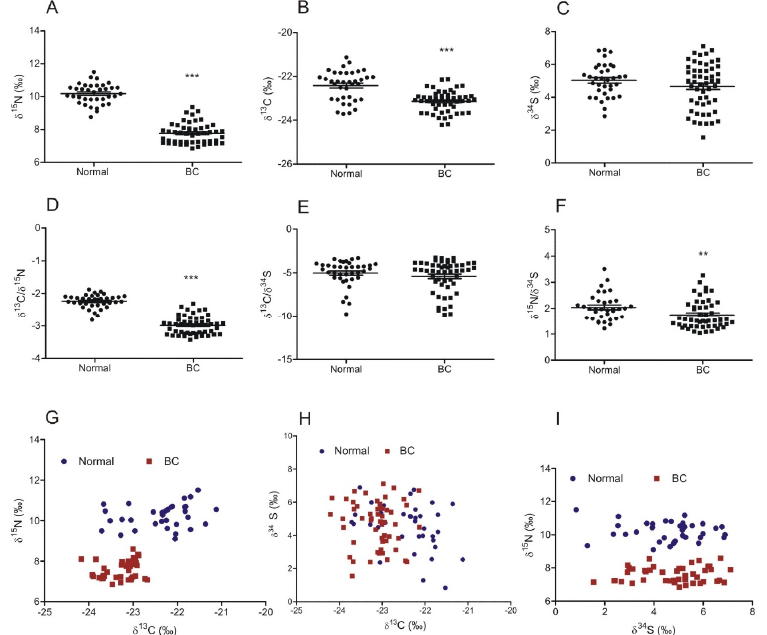
Figure 1. The abundance of natural stable isotopes of nitrogen, carbon, and sulfur in normal urothe- lium and bladder cancer (BC). Level of δ 15 N ( A ), δ 13 C ( B ) , and δ 34 S ( C ) and the ratio of δ 13 C/ δ 15 N ( D ), δ 13 C/ δ 34 S ( E ) , and δ 15 N/ δ 34 S ( F ) in urothelium and bladder cancer samples (mean ± SEM). ( G – I ) Scat- ter plots showing the relationship between the abundance of isotope pairs ( δ 13 C– δ 15 N, δ 13 C– δ 34 S, and δ 34 S– δ 15 N, respectively) in each sample of normal urothelium and bladder cancer. ** p < 0.01; *** p < 0.001.